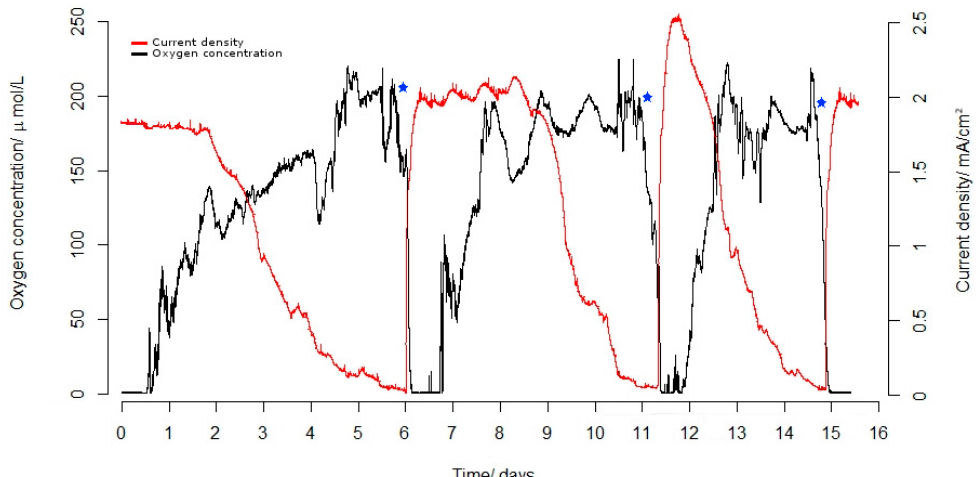
Figure 1. Biofilm current density (CD) and dissolved oxygen (DO) concentration profiles at a constant depth of 100 µ m on the apparent surface of the biofilm during three consecutive feeding cycles. The blue stars denote spiking with sodium acetate (to a theoretical concentration of 10 mM).